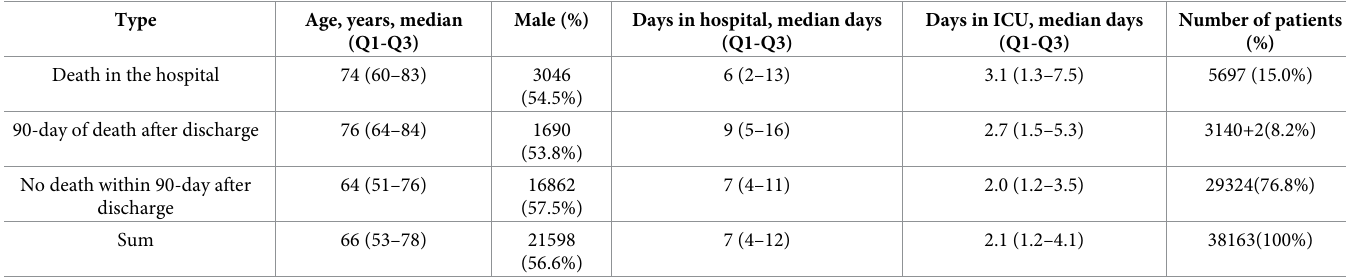
Table 1. Patients’ basic information in